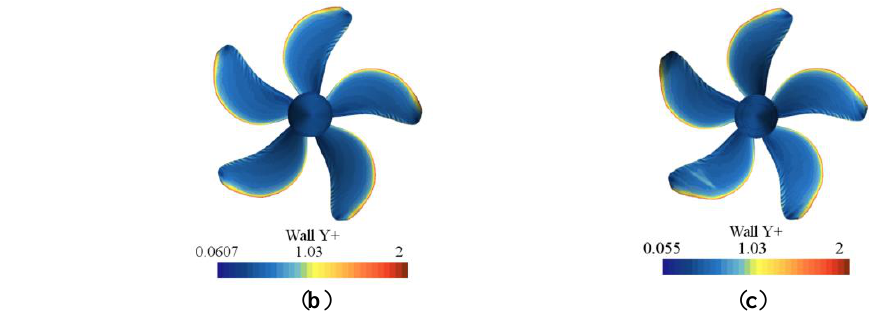
Figure 7. Streamline distribution on suction side surface of propeller Kap00 ( a ), Kap02 ( b ) and Kap04 ( c ) ( J = 0.8, 12 rps).